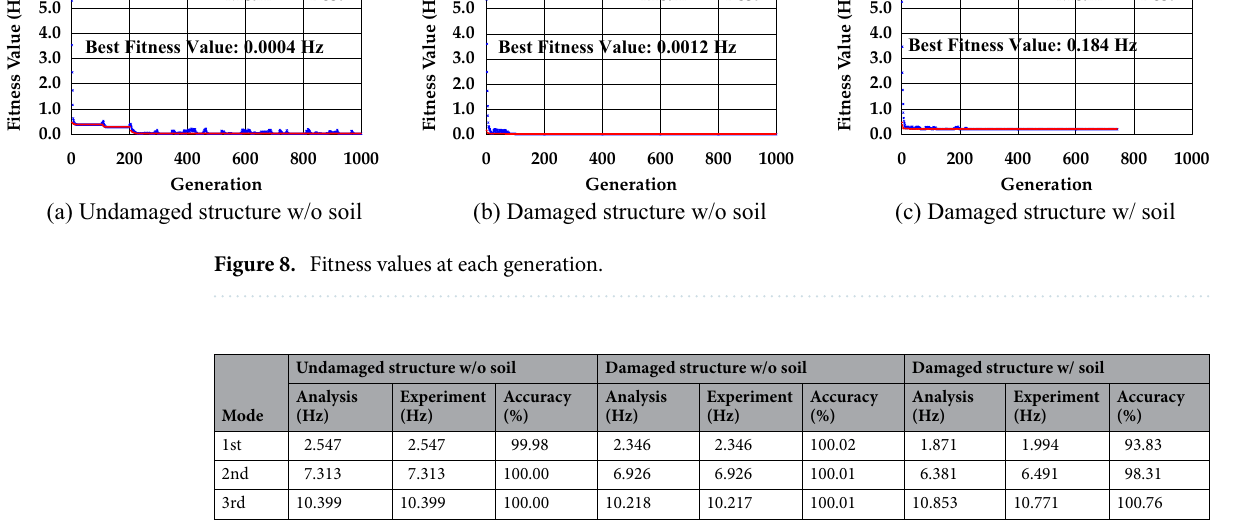
Table 4. Comparison of natural frequencies between model updating and experiment